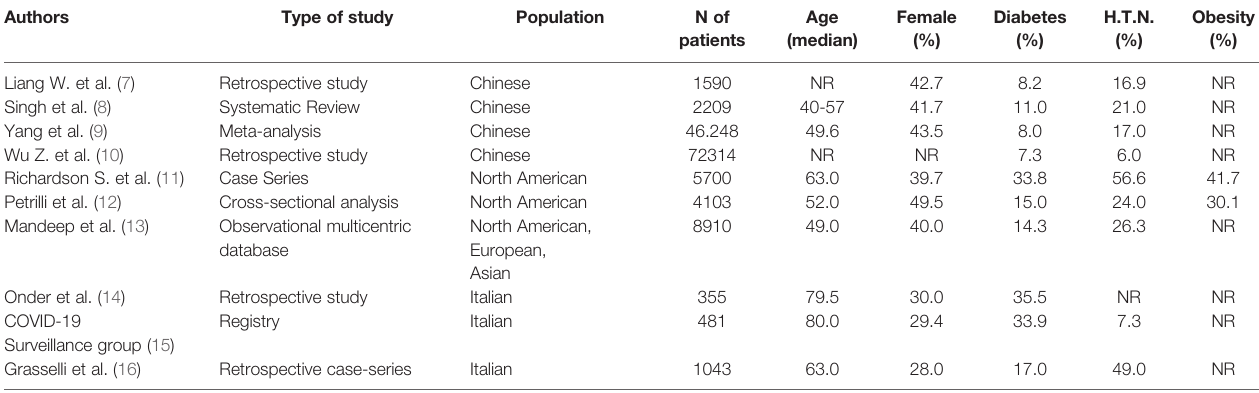
TABLE 1 | Prevalence of type 2 diabetes, hypertension and cardiovascular disease in various studies on COVID-19 patients.